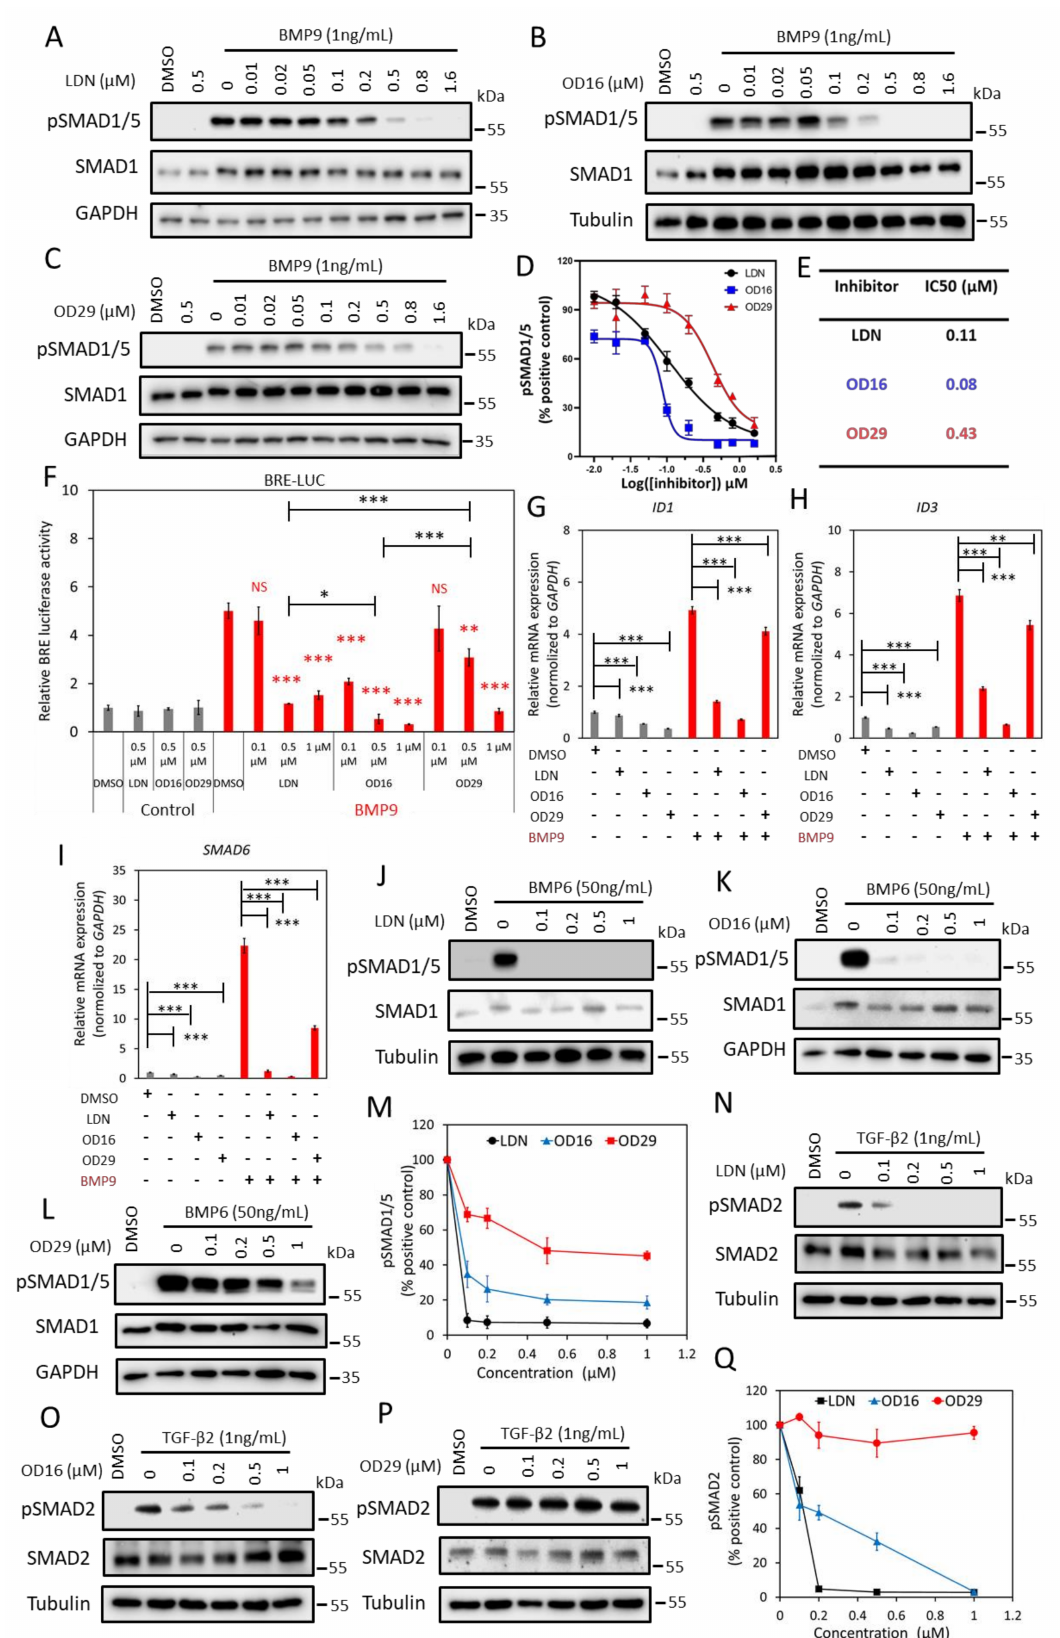
Figure 2. OD16 and OD29 inhibit BMP, but not TGF- β signaling in EA.hy926 cells. ( A – C ) Western blot analysis of the dose- dependent effects of LDN-193189 ( A ), OD16 ( B ), and OD29 ( C ) on BMP9 (1 ng/mL)-induced SMAD1/5